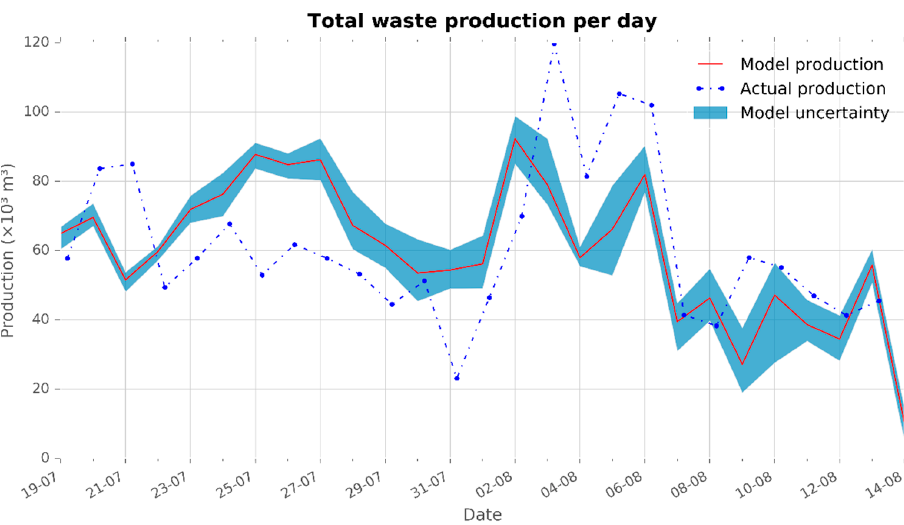
Figure 18. Comparison of daily production of waste, Experiment 3.